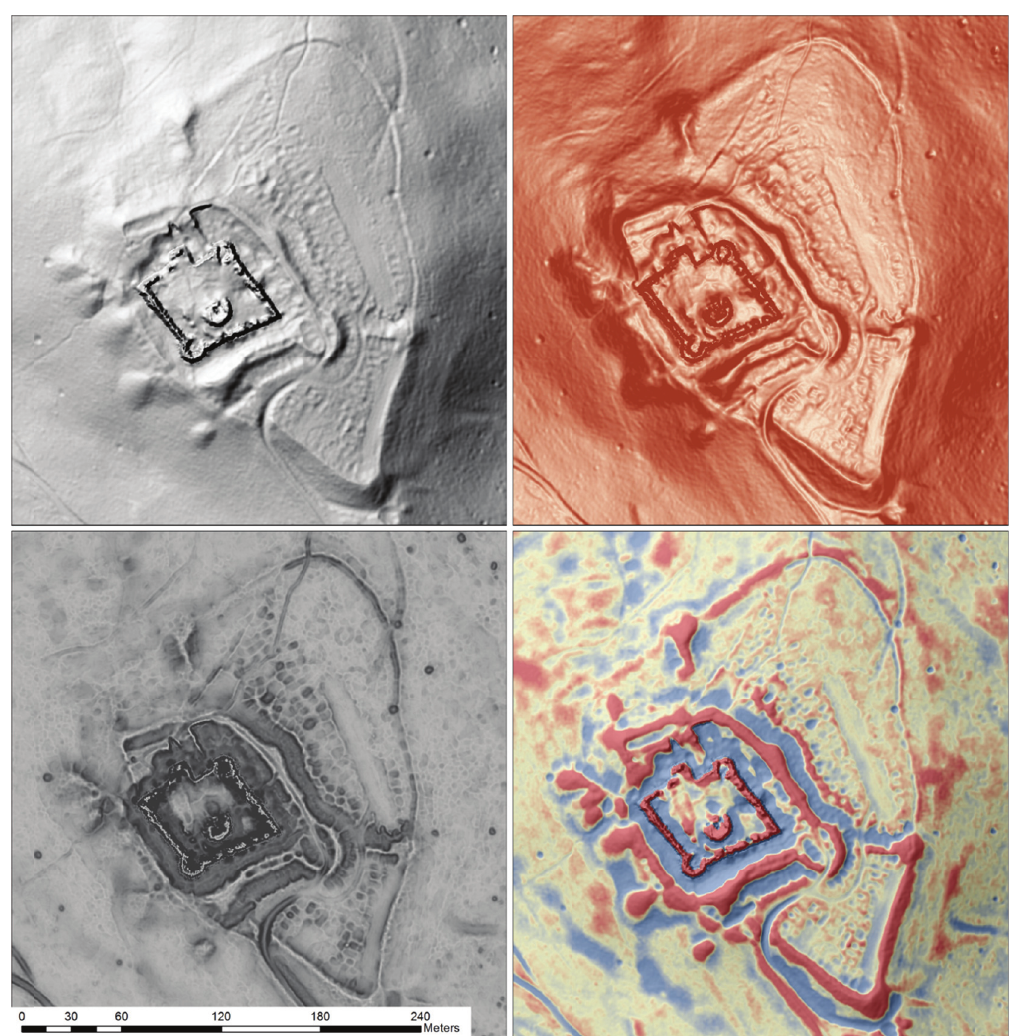
Figure 2. Visu ualisation of a filte ered DTM of a M Medieval ruined c of hillshade a and slope; lower l left: positive and